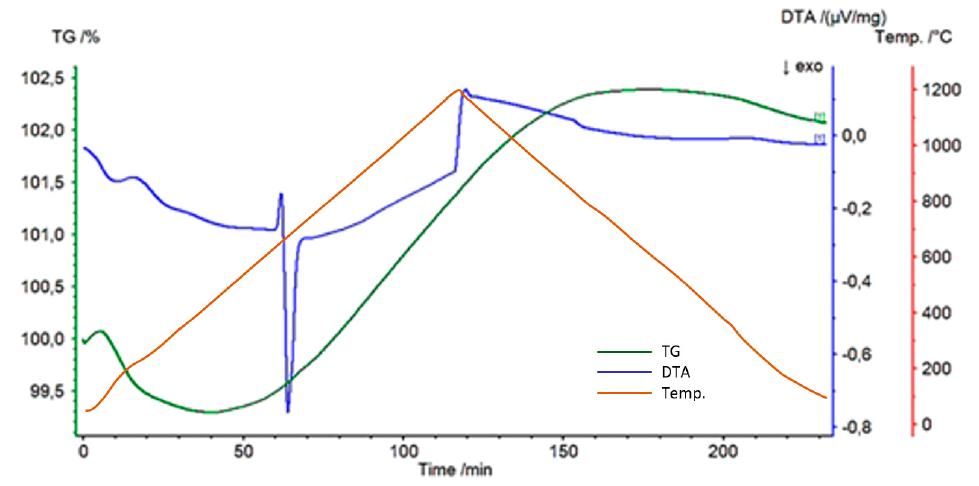
Figure 5. Thermogravimetric analysis of an Al-Ti-C system (TG). For material after TG investigation, phase analyses were conducted to determine new phases created in the Al-Ti-C system at a temperature of 1200 °C. Figure 6 presents the result of the examination. A reaction between the aluminium and titanium led to AlTi 3 phase creation, whilst the aluminium–carbon system revealed a tendency to creation of a metastable Al 4 C 3 phase. There was no reaction between the titanium and carbon components.